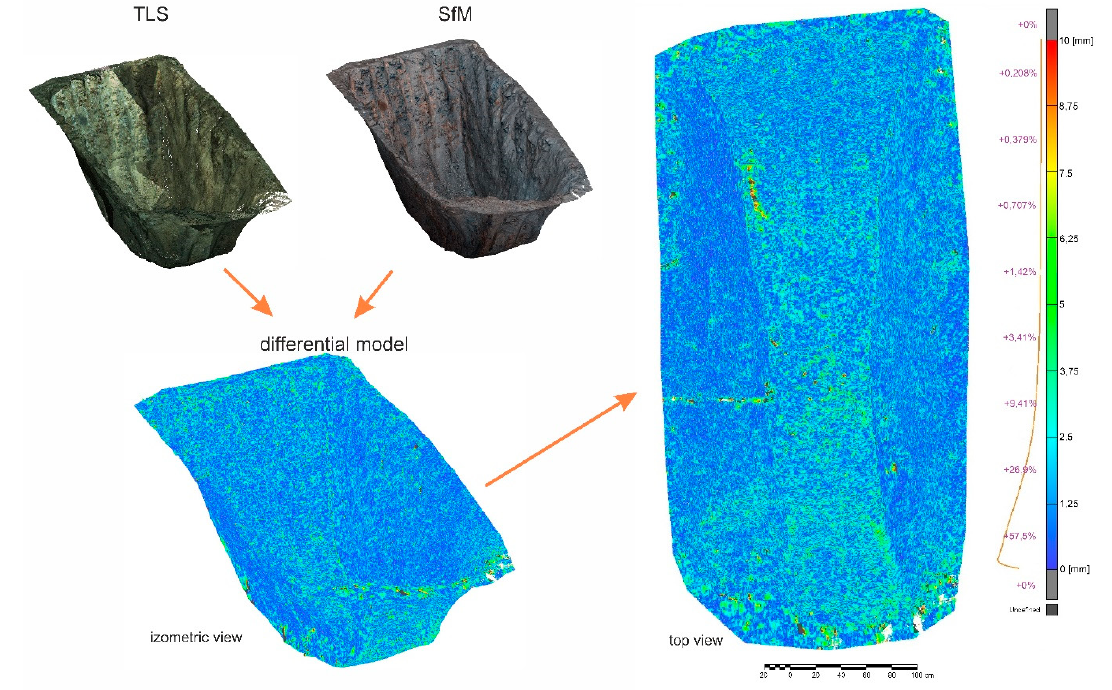
Figure 11. Difference model between point cloud from photogrammetric processing and from TLS—Probe 1.